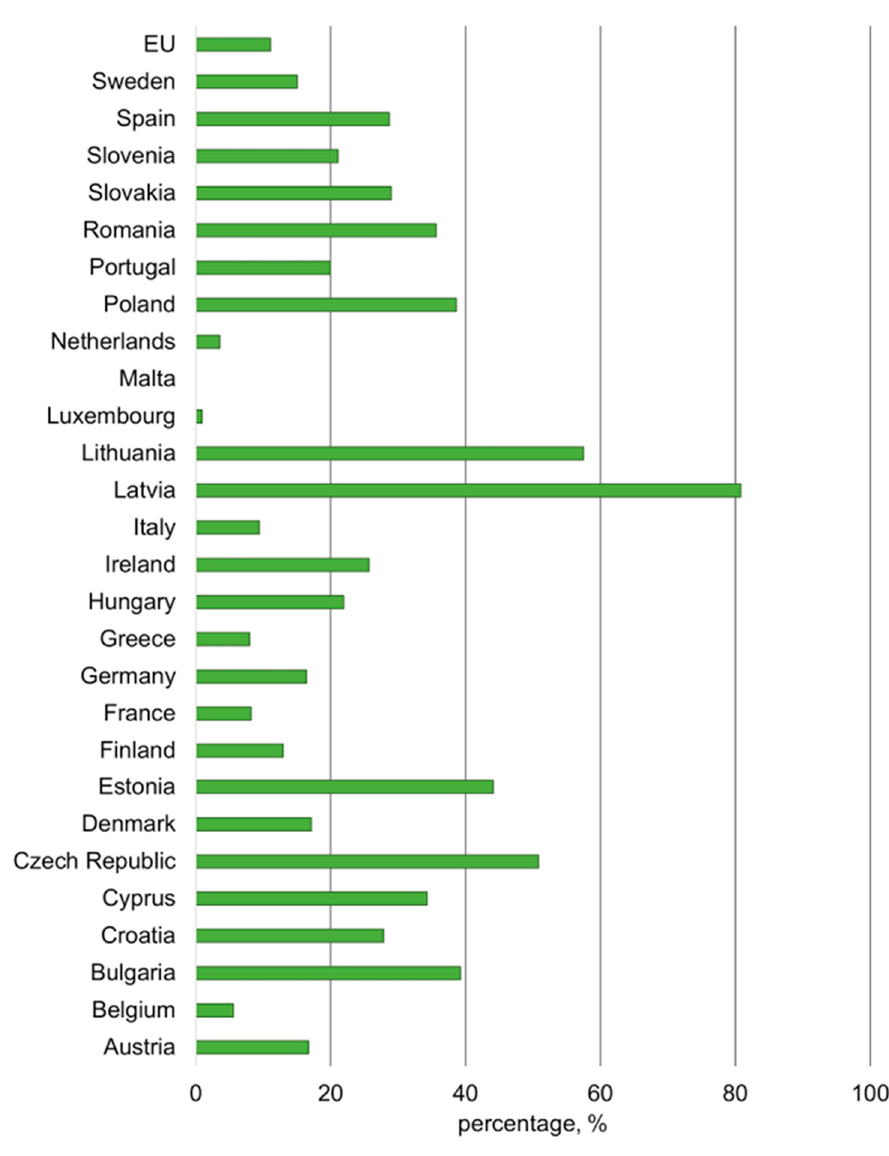
Figure 4. Percentage share of fast chargers in public charging points in the EU, by country.